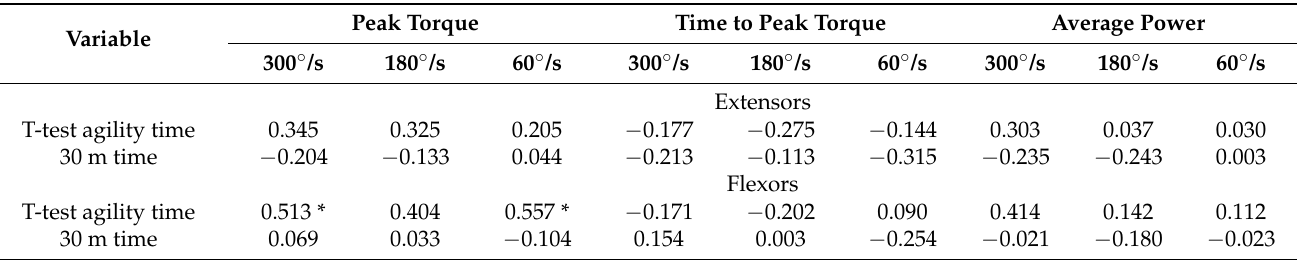
Table 3. Correlation coefficients for the relationships between time for T-Test of Agility, time for 30 m and peak torque, time to peak torque, average